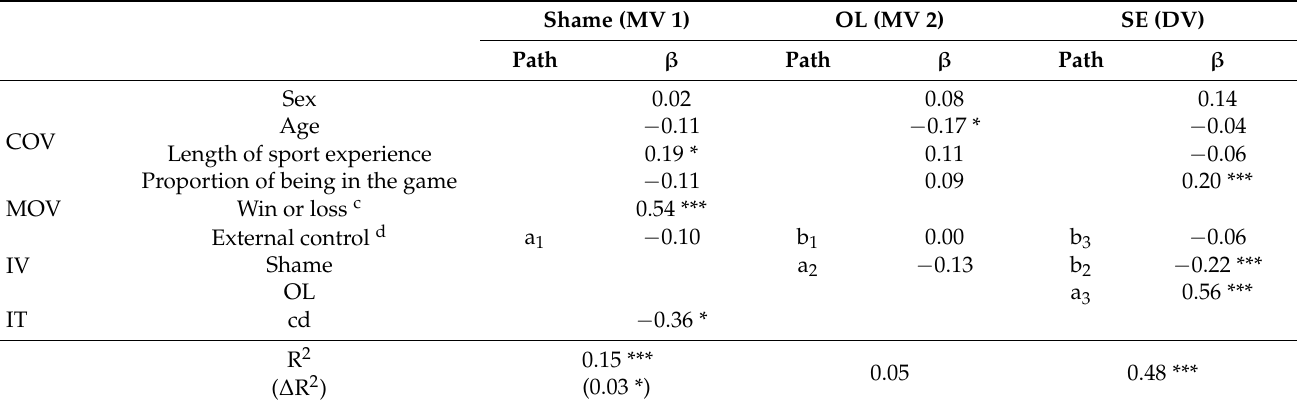
Table 6. Analysis 2: Double-Mediating Effects in Winning and Losing